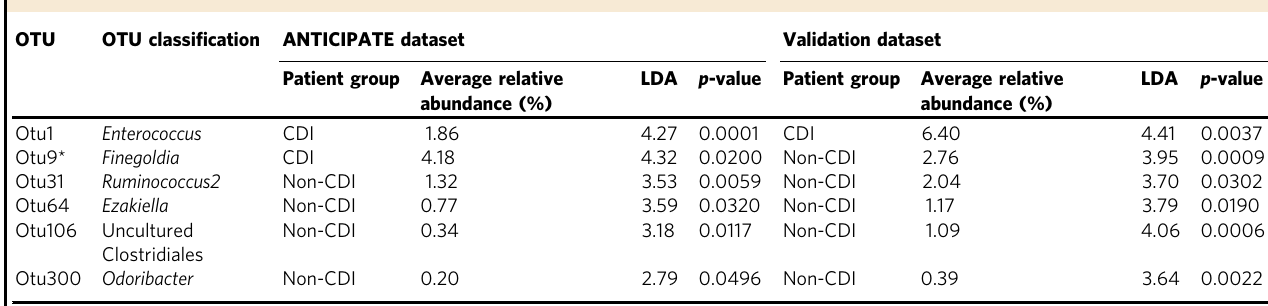
Table 3 Validation of identi fi ed microbiota-based markers predictive of